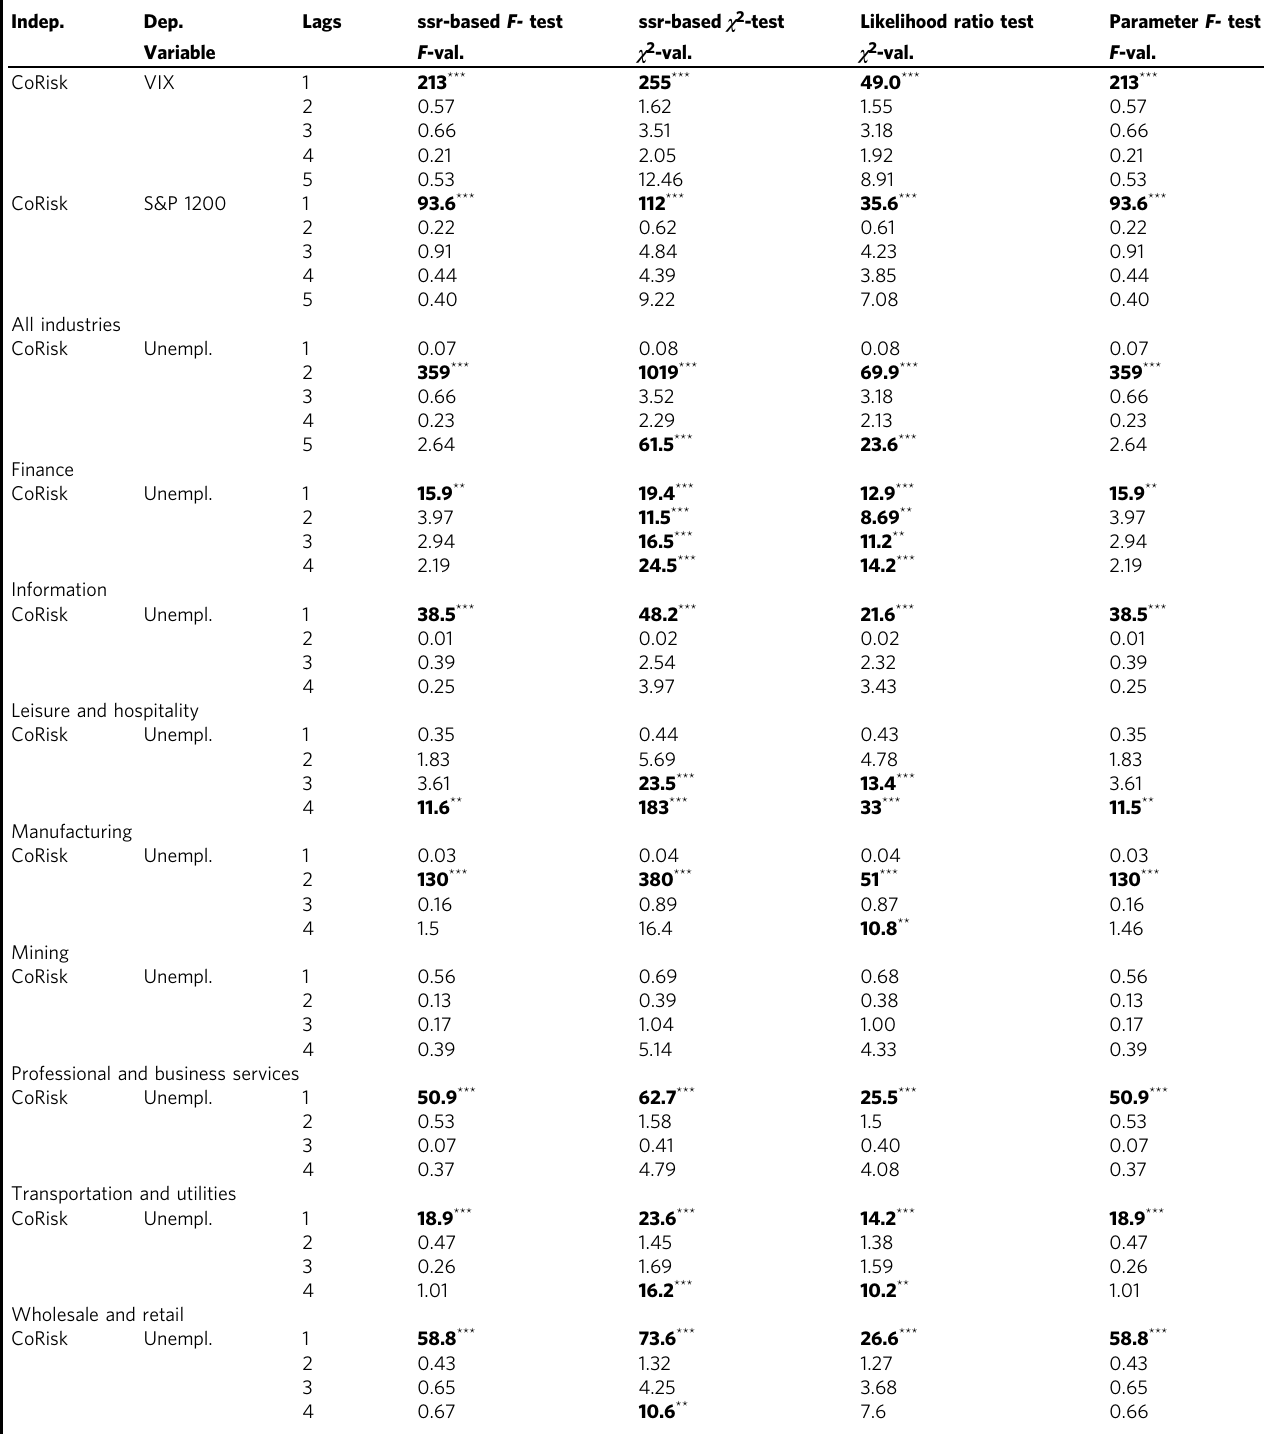
Table 2 Granger causality test results.